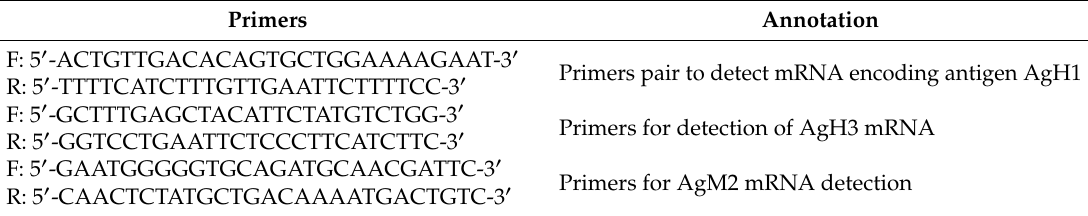
Table 1. Primers used to detect synthesis of the target mRNAs in